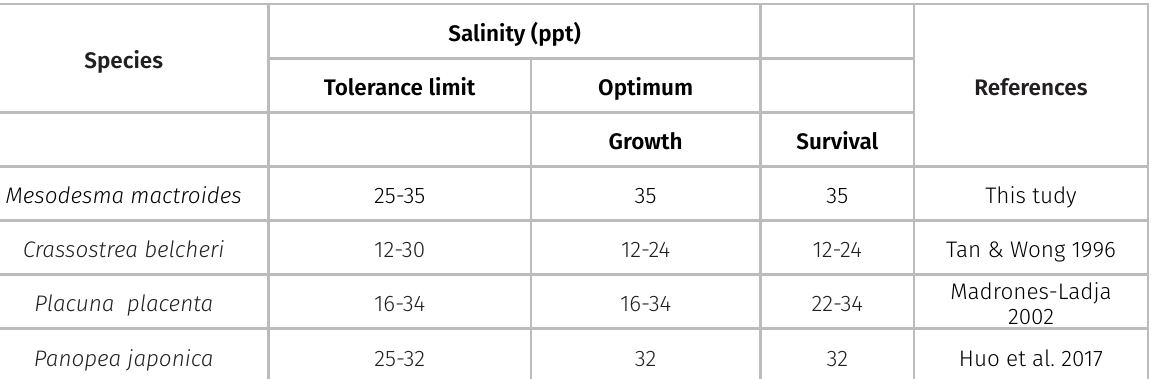
Table III. Optimum salinity levels and tolerance limit for larval growth and survival of Mesodesma mactroides and other bivalve